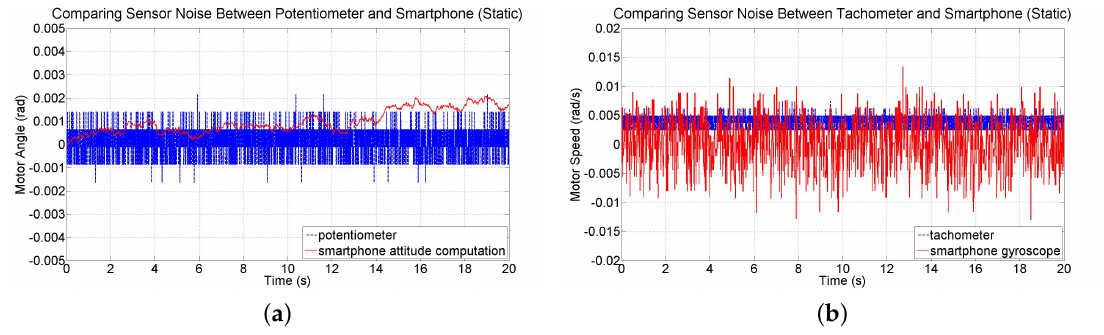
Figure 10. Comparisons between ( a ) the smartphone attitude sensing and potentiometer readings and ( b ) the smartphone gyroscope readings and tachometer readings while the motor is not being driven.